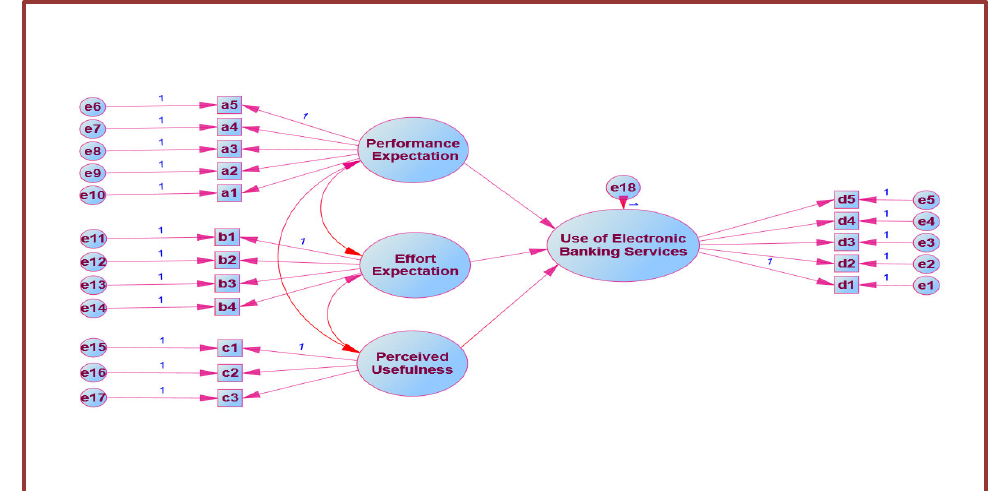
Fig. 2. The structural model displaying the path